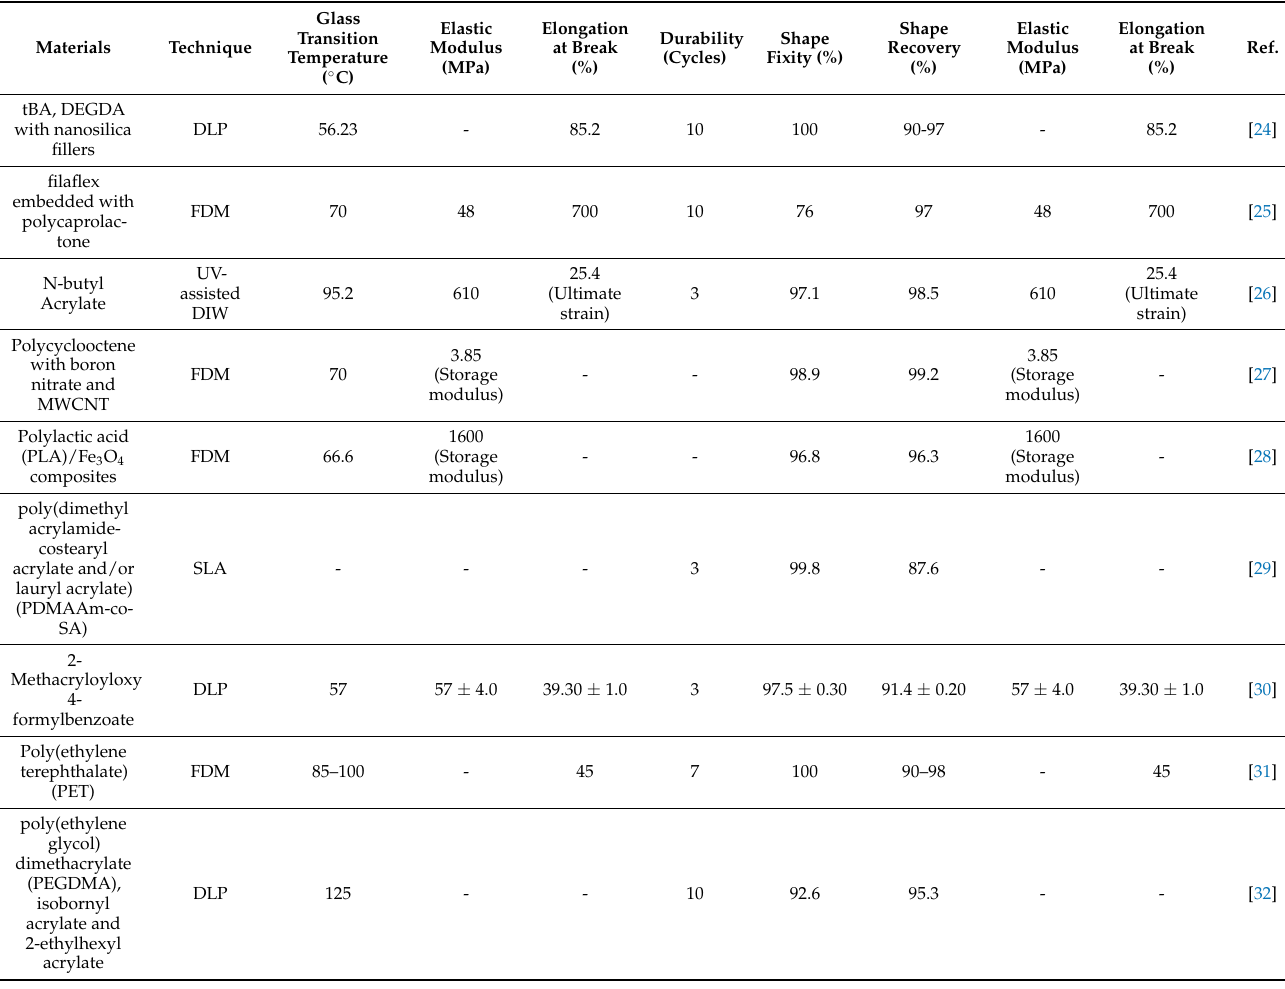
Table 2. Summary of recent studies in the fabrication of SMPs using AM technologies and their impact on mechanical properties including shape fixity and shape